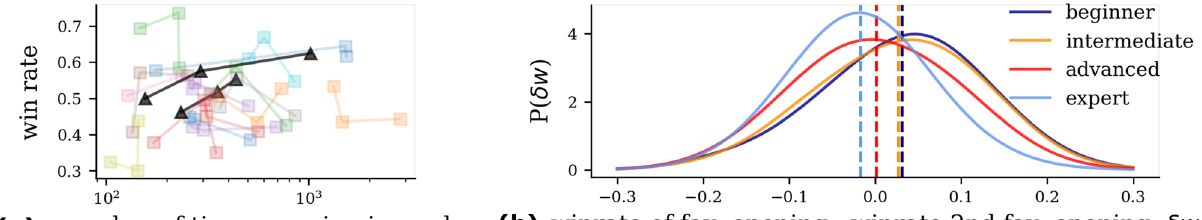
Figure 4. Sub-optimal opening encounters. ( a ) Winrate of top 3 openings of a player against opening frequency. Each connected curve corresponds to a player. We show 15 random players who play at least 100 games with each of their top 3 openings. Curves of players whose winrate increases monotonically with the frequency of the associated opening are depicted in black and are deemed optimal . ( b ) Distribution of difference δ w in winrate of associated to favourite and second favourite opening and winrate of their second favourite opening for the whole population of players. Different curves correspond to different skill levels. Dashed lines indicate mean values of the distributions. Stronger players encounter less optimal openings more often than weaker players.